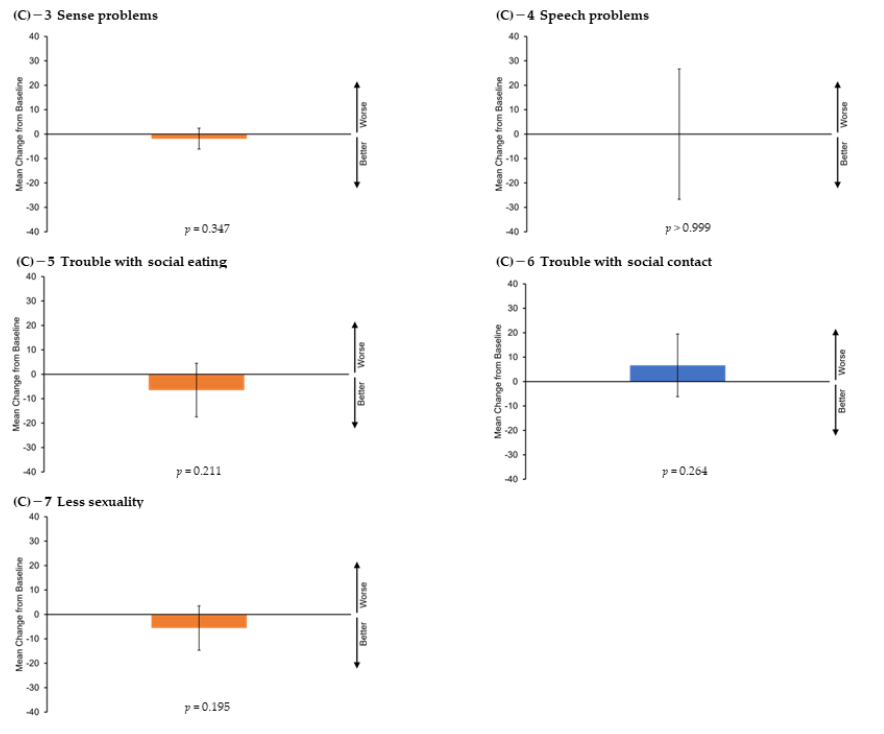
Figure 1. Quality of life assessments. ( A ) Functional scales (physical, role, emotional, cognitive, and social activities) and ( B ) global health status were assessed using the EORTC QLQ-C30. ( C ) Domain scales (pain, swallowing, sense problems, speech problems, trouble with social eating, trouble with social contact, and reduced sexuality) were assessed using the QLQ-H&N35. All scales ranged from 0 to 100, and score changes of at least 10 points were considered clinically significant. Higher values for functional and domain scales indicate poor functioning, whereas higher values for global health status indicate better functioning. The I bar indicates 95% confidence intervals. QOL, quality of life; EORTC QLQ- C30, European Organization for Research and Treatment of Cancer Quality of Life Questionnaire Core 30 Module; QLQ-H&N35, Quality of Life Questionnaire Head and Neck Cancer Module. Table 3. Changes in quality-of-life